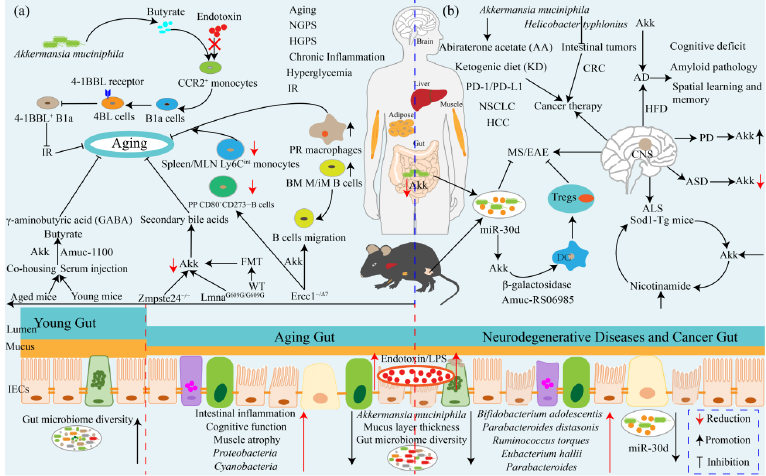
Figure 3. The potential beneficial effects of Akk towards anti-aging, anti-neurodegenerative disease, and anticancer therapy via multiple different signaling pathways mediated by the gut – brain axis. ( a ) Akk and its metabolite butyrate blockade endotoxin-induced CCR2 + monocyte activation, which can convert B1a cells into 4BL cells to inhibit 4-1BBL + B1a cell accumulation by activating 4-1BBL